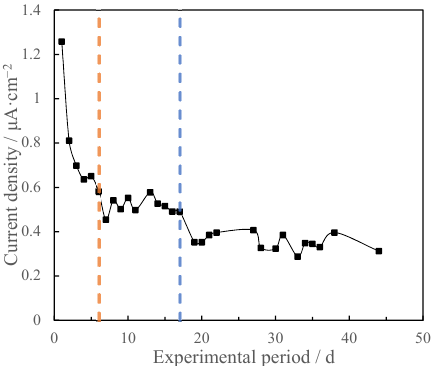
Figure 4. The average current density of the single row anode.